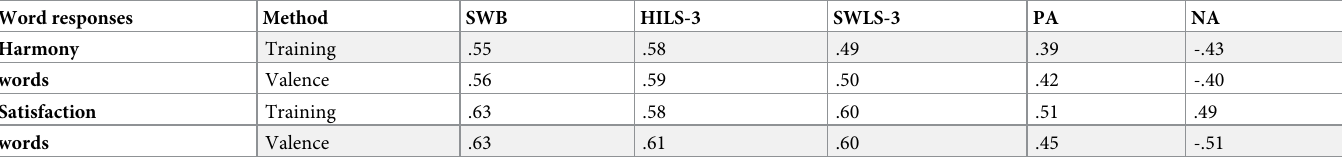
Table 4. Relationship between HIL and SWL words and numerical SWB